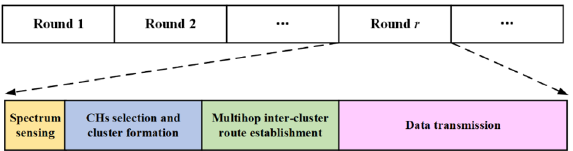
Figure 1. Round structure of ISSMCRP